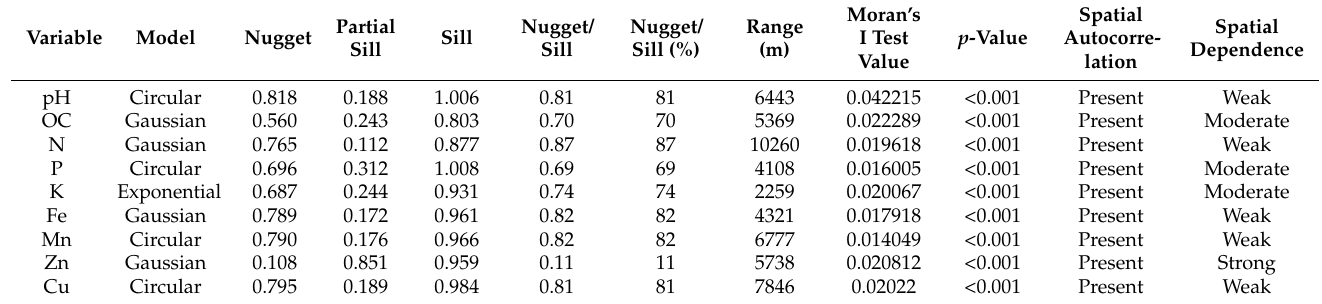
Table 5. Semivariogram parameters of soil property residuals in India’s north-eastern Himalayan